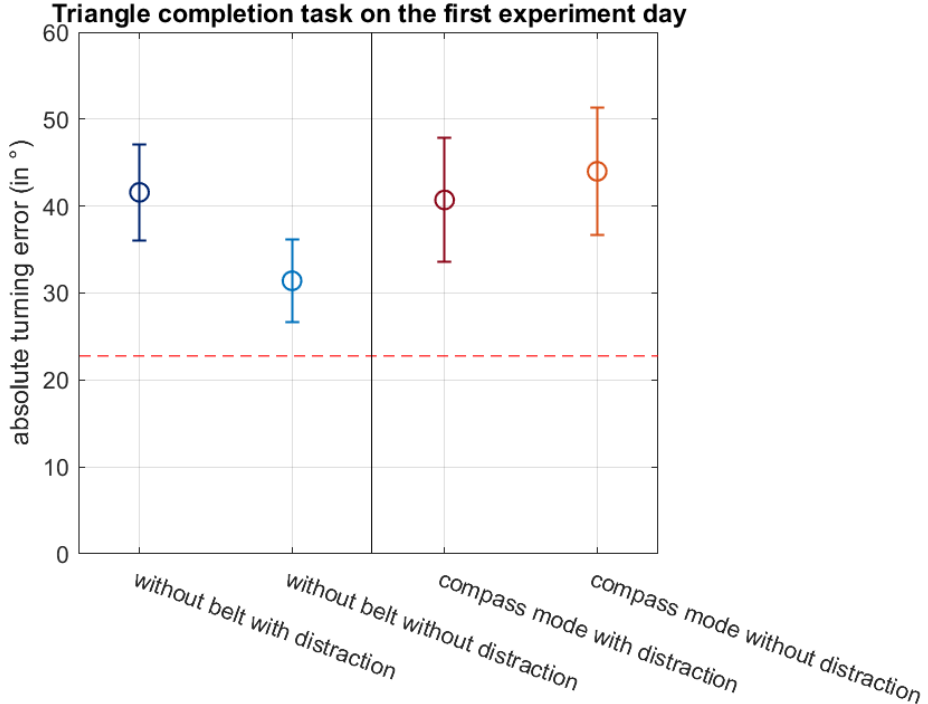
Figure 10. This figure shows the absolute turning errors of the participants during the triangle completion task in the four conditions without belt with distraction, without belt with distraction, with belt with distraction and with belt without distraction on the first experiment day. The circles indicate the mean and the whiskers the SEM. The red dotted line at 22.5° indicates the angular range that the correctly activated single vibromotor covers before the vibrating signal moves to the neighbouring vibromotor.